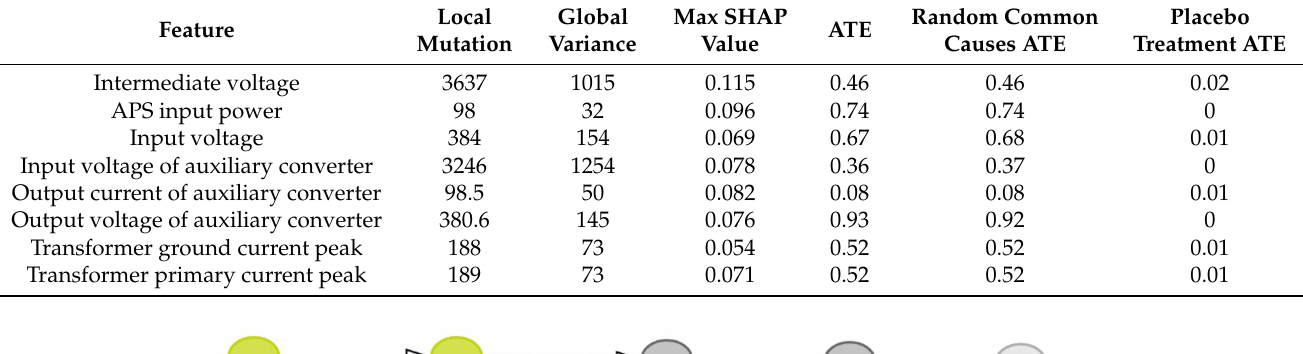
Table 3. Causal inference experimental data sheet.